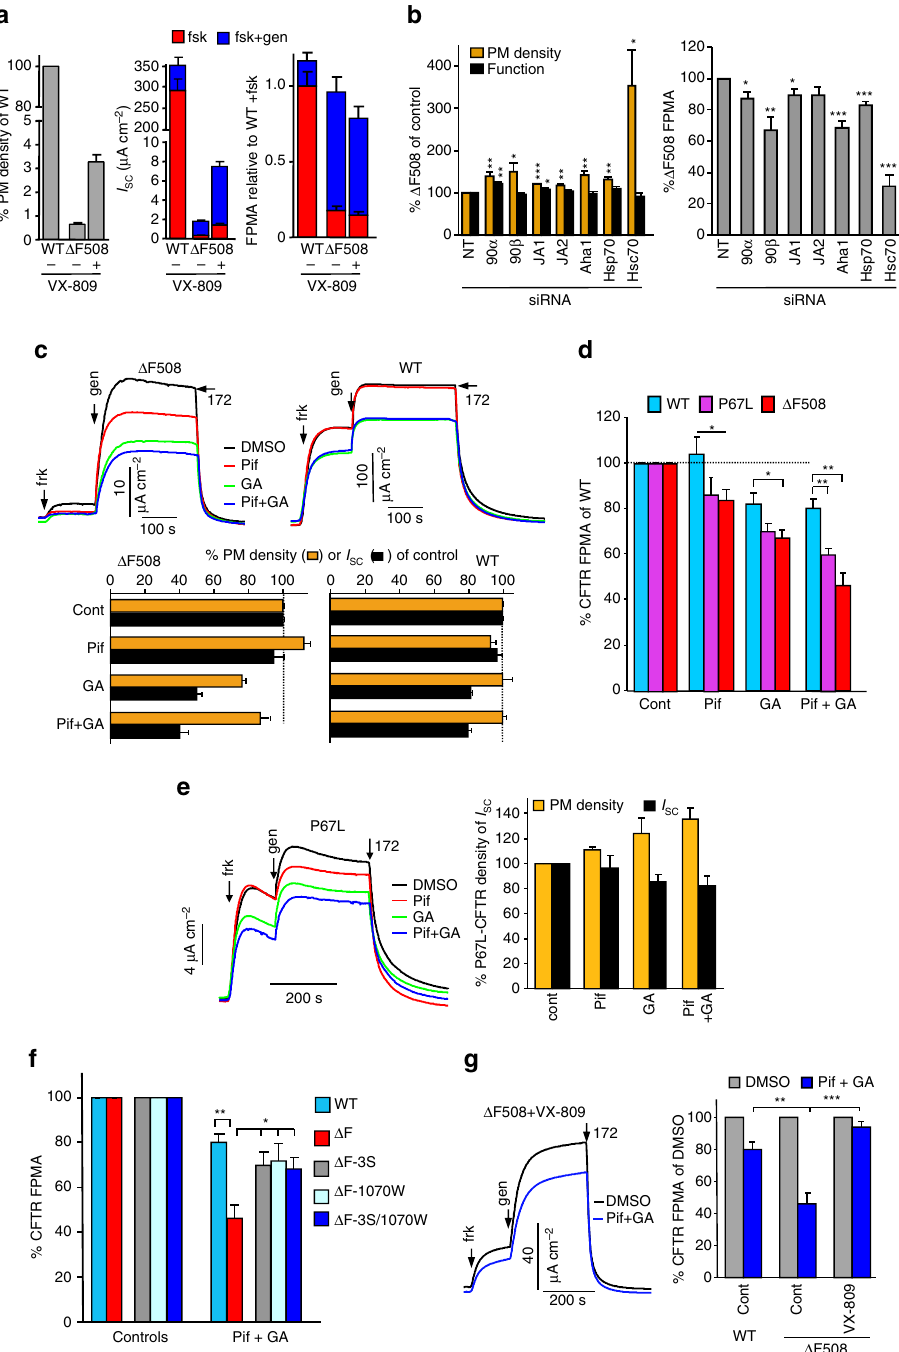
Fig. 2 Molecular chaperone activity maintains the limited transport competence of Δ F508- and P67L-CFTR. a FPMA of WT and Δ F508-CFTR calculated from PM density and short-circuit current ( I sc ) with and without 24 h 3 μ M VX-809 rescue, expressed as percentage of WT-CFTR expressing CFBE ( left panel ). I sc was measured after sequential addition of 20 μ M forskolin (fsk) and 100 μ M genistein (gen), followed by CFTR inhibition with Inh 172 (172, 20 μ M). The FPMA ( right panel ) was calculated as the ratio of PM density and I sc , and normalized to WT. Means ± SEM, n = 3; error bars in the right panel are error propagation. b The effect of chaperone or co-chaperone knockdown on PM density, function and FPMA of the Δ F508-3HA in CFBE. The rescued Δ F508-CFTR (30 °C, 48 h) was unfolded for 2 h at 37 °C. Hsp90 α (90 α ), Hsp90 β (90 β ), DNAJA1 (JA1), DNAJA2 (JA2), Aha1, Hsp70, and Hsc70 were silenced with 50 nM siRNA. Non-targeted siRNA served as controls. Function was determined by YFP quenching assay. c The effect of Hsc70 and Hsp90 inhibition on the PM density and function of the Δ F508- and WT-CFTR-3HA in CFBE. The rescued Δ F508-CFTR (30 °C, 48 h) was unfolded (2 h at 37 °C) in the presence of 5 μ M Pif and/or 5 μ g ml − 1 GA. I sc was measured as in a . Representative measurements are in the top panels . d The effect of Hsc70 and Hsp90 activity on the FPMA of the Δ F508- and P67L-CFTR in CFBE cells. Experiments were performed as in c . e I sc and PM density of P67L-CFTR in CFBE as described in c . f The effect of Hsc70 and Hsp90 activity on Δ F508-CFTR FPMA in CFBE cells. CFBE cells, expressing Δ F508-CFTR with second site mutations or rescued Δ F508-CFTR (30 °C, 48 h), were treated for 2 h at 37 °C with 5 μ M Pif and 5 μ g ml − 1 GA. Experiments were performed as in c . g Conformational rescue of the Δ F508-CFTR by low temperature plus VX-809 (3 μ M, 24 h) prevents the loss of Δ F508-CFTR FPMA by Pif + GA in CFBE cells. Experiments were performed as in c . Data are means ± SEM, n = 3 – 4. * P < 0.05, ** P < 0.01 and *** P <